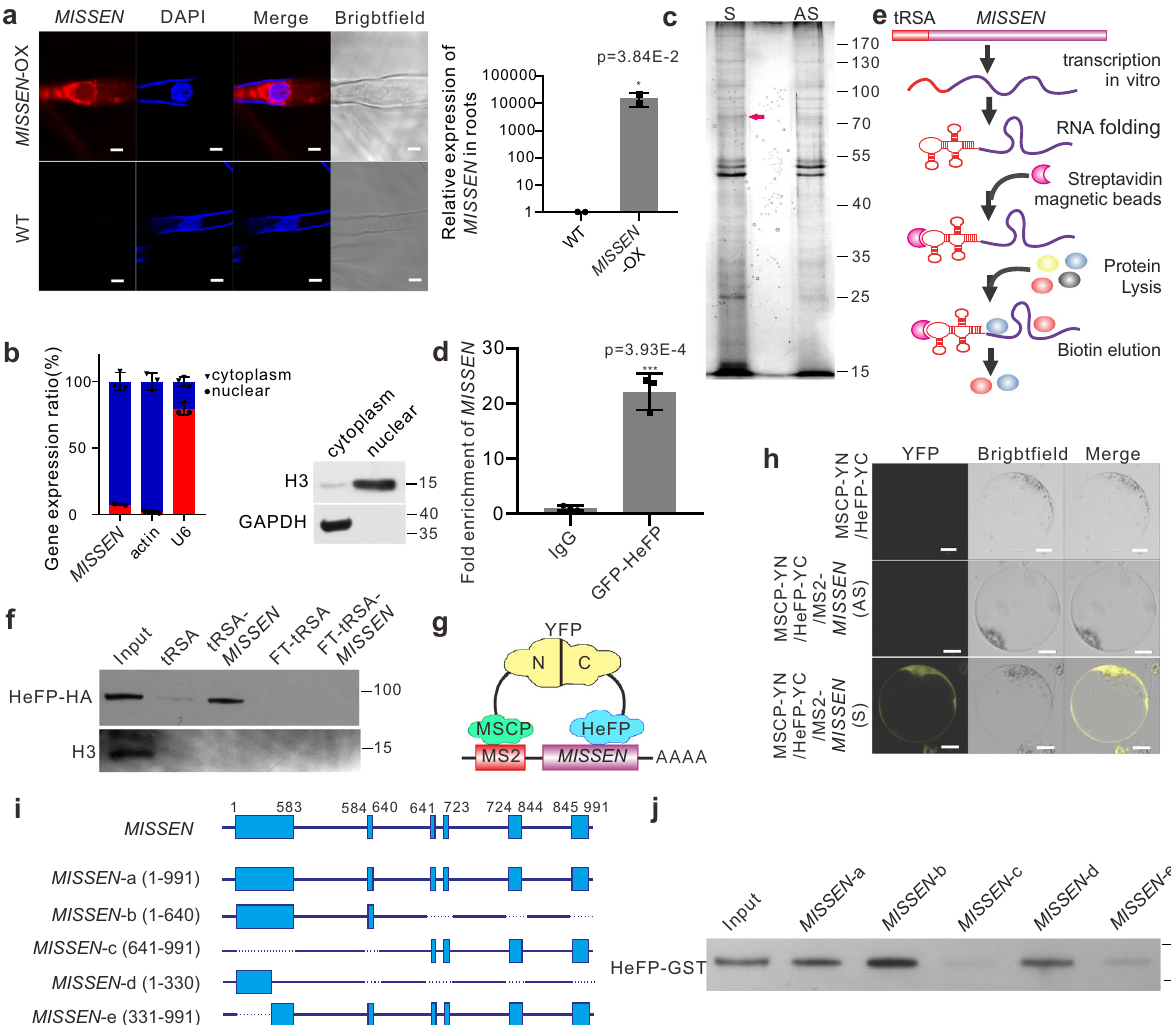
Fig. 3 The lncRNA MISSEN interacts with HeFP. a Subcellular localization of Cy3-labeled MISSEN . Scale bars, 5 µ m. The expression level of MISSEN in roots of WT and MISSEN -OX plants. Values are the means± SD ( n = 3 replicates, normalized against ACTIN2 ). b Nuclear separation experiments with qRT- PCR analysis shows that MISSEN is predominantly localized in the cytoplasm. Values are the means ± SD ( n = 3 replicates). c Silver staining of the MISSEN RNA pull-down assay. The red arrow indicates HeFP. d – f RNA immunoprecipitation assay ( d ) and tRSA-RNA pull-down assay ( e , f ) of MISSEN and HeFP. Values are the means ± SD ( n = 3 replicates, normalized against ACTIN2 ). “ FT ” in f means “ Flow through ” . The experiment was repeated three times with similar results and one representative result was shown. Schematic diagram of tRSA-RNA pull-down assay was showed in e . g Schematic diagram of the TriFC assay. h TriFC assay of MISSEN and HeFP. nYFP was fused to MSCP, and cYFP was fused to HeFP, 12xMS2 nucleotide sequences were fused to sense or antisense MISSEN . Scale bars, 10 µ m. The experiment was repeated three times with similar results and one representative result was shown. i MISSEN fragments used for binding domain identi fi cation. j Identi fi cation of the HeFP-binding domain on MISSEN by RNA pull-down and western blot. The experiment was repeated three times with similar results and one representative result was shown. Signi fi cant differences were identi fi ed at the 5% (*), 1% (**), 0.1% (***) and <0.01% (****) probability levels using two-tailed paired t -tests.